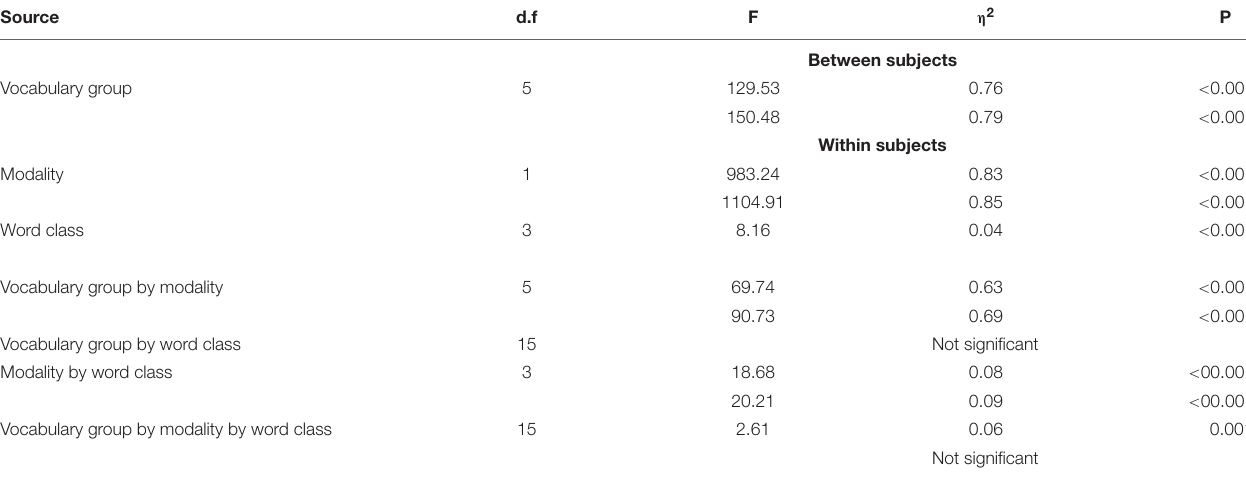
TABLE 8 | Analyses of variance examining proportion of words known in different word classes in both comprehension and production modalities, as a function of vocabulary